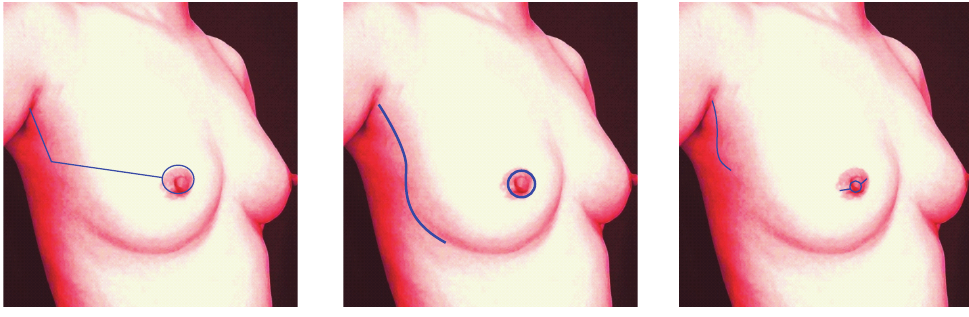
Figure 1: Classification of skin incisions for SSM.